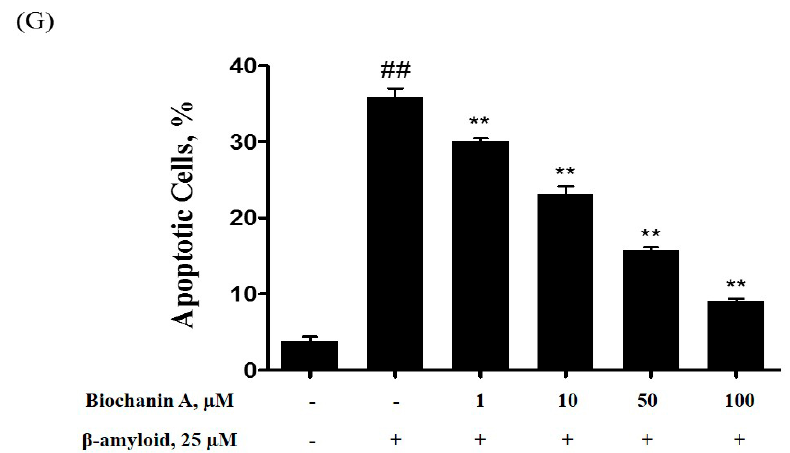
Figure 2. Effect of biochanin A on A β 25–35 -induced apoptosis as measured by flow cytometry. After PC12 cells were plated, they were either unexposed (control) or exposed to 25 μ M A β 25–35 with or without biochanin A (1, 10, 50, and 100 μ M). After 24 h of treatment, the treated PC12 cells were harvested and labeled with annexin V–FITC and PI and further analyzed by flow cytometry. The figure shows representative flow cytometric quadrants and histogram. ( A ) Control; ( B ) 25 µ M A β 25–35 alone;